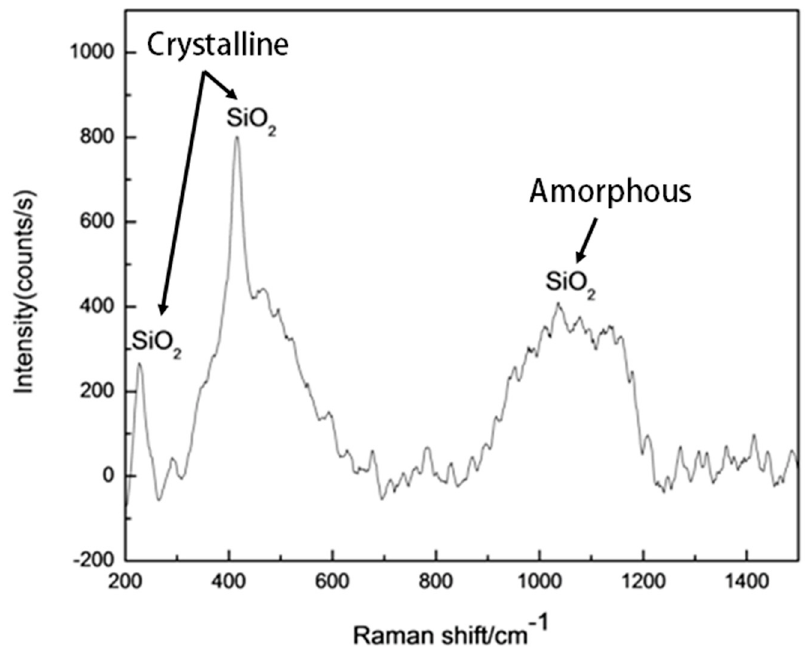
Figure 6. Raman spectrum of the MoSi 2 -Si 3 N 4 /SiC coating after oxidation at 1773 K for 150 h [26].